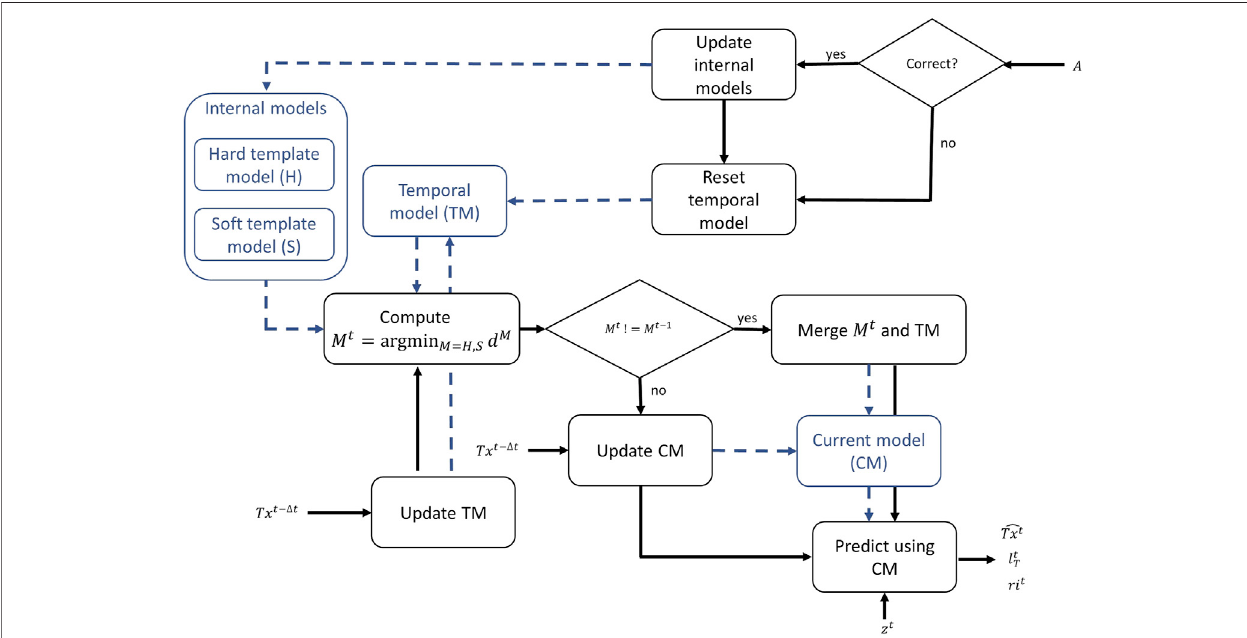
FIGURE 4 | Internal model fl ow-chart: during the trial, the internal model continuously uses incoming data Tx t − Δ t to determine which model can better fi t the collected data. The same data are then used to update both TM and CM according to Eq. 1 . When the closest model ( M t ) changes from H to S or vice versa , the CM is generated by merging M t and TM (see Eq. 4 ). The black lines correspond to the fl ow chart and the blue ones to data storage. The prediction of ^ Tx t and the values for l t T and ri t isthengivenbyshowingthe CM levelcorrespondingtotheheight z t .Whentheusergivestheanswer A , TM isresetandtheinternalmodelsareupdatedifthe given answer is